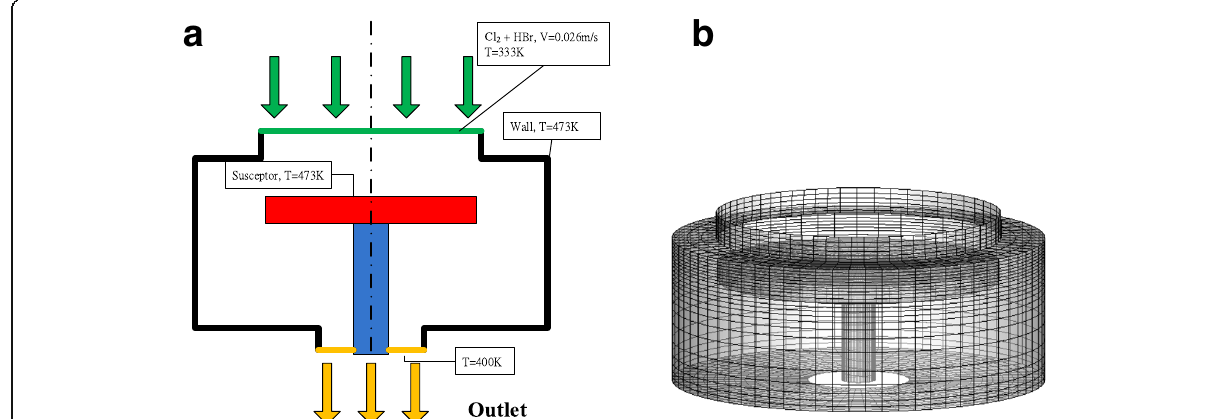
Fig. 1 Physical model for numerical simulation of plasma reactor. a The sketch of the reactor chamber with prescribed boundary conditions. b Mesh system for numerical